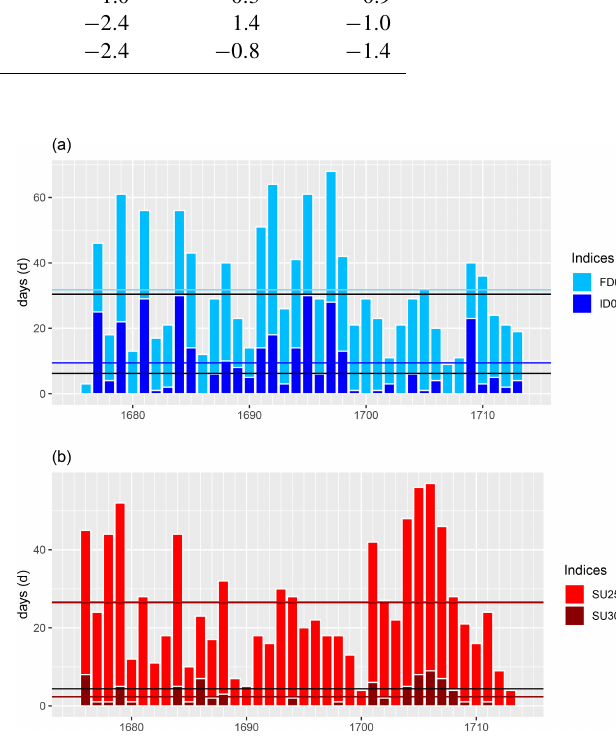
Figure 6. (a) Calculation of the indices FD0 (number of days on which the temperature falls below 0 ◦ C) and ID0 (number of days on which the temperature stays below 0 ◦ C) for the cold season (DJF). The horizontal lines indicate the respective average values over the entire period ( FD0: sky blue; ID0: blue; FD0 Ref : upper black line; ID0 Ref : lower black line). Meanwhile, panel (b) shows the calcu- lation of the indices SU25 (days with a temperature value above 25 ◦ C) and SU30 (days with a temperature value above 30 ◦ C) for the warm season (JJA). The horizontal lines indicate the respective average values over the entire period (SU25: red; SU30: dark red; SU25 Ref : upper black line; SU30 Ref : lower black line). the percentage change in Morin’s TCC series is shown per decade, with the mean of the ERA5 data from 1981 to 2010 as a reference. The seasonally mean TCC from 1665–1713 shows a significantly lower value for all seasons. The highest anomalies are observed in 1665–1680, when for instance the spring season has a 27.0 % (1665–1670) and a 30.4 % (1671–